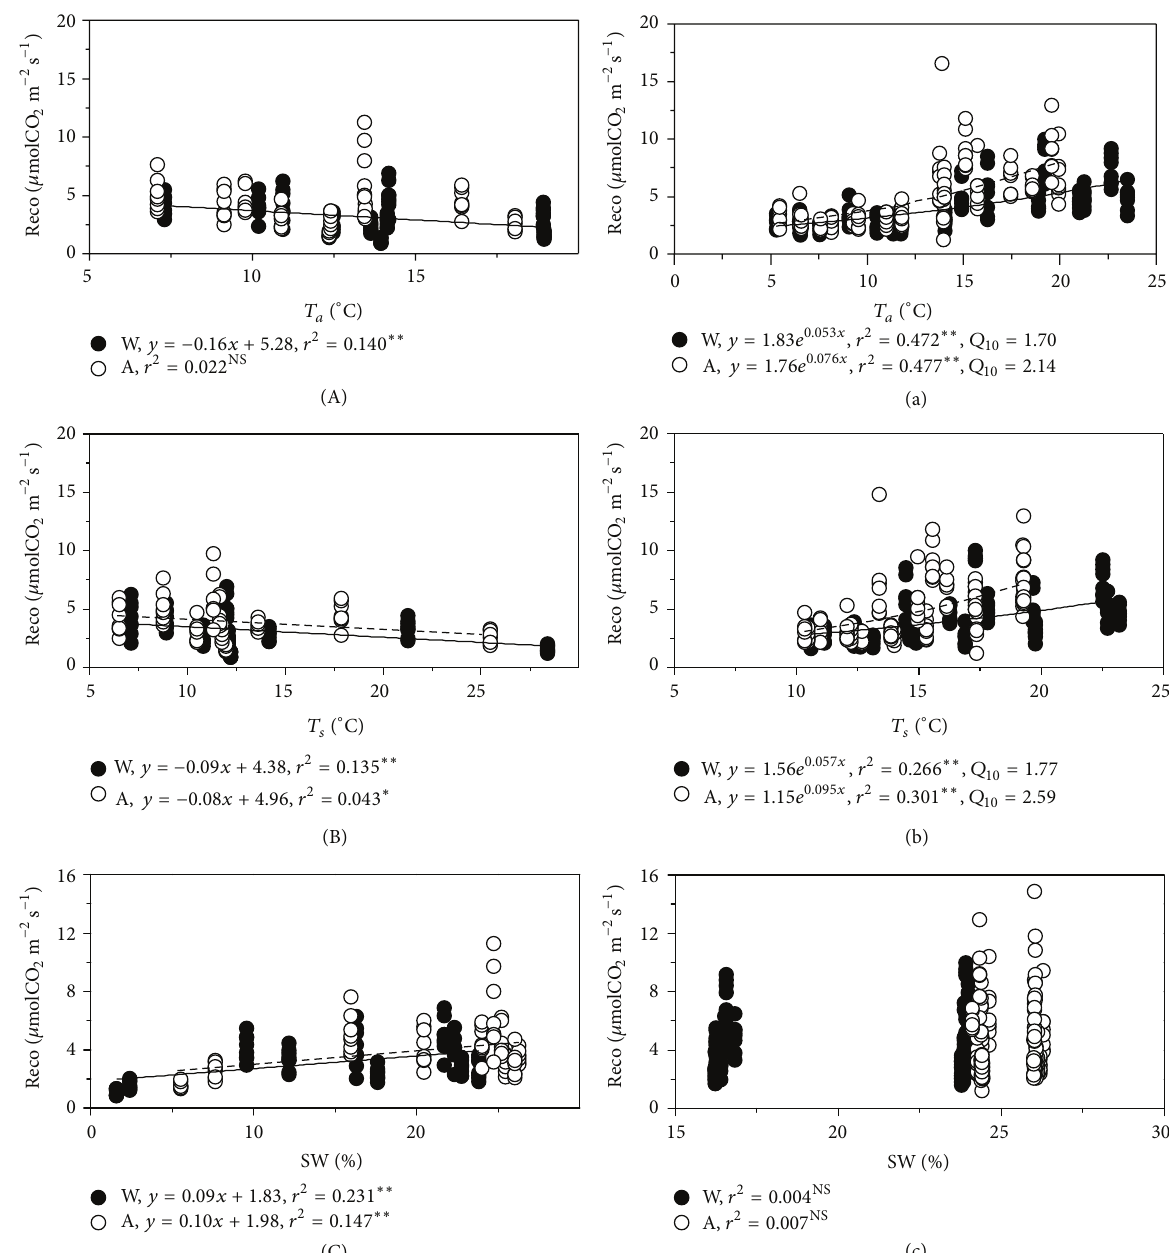
Figure 6: Dependence of soil respiration on air temperature (A, a), soil temperature (B, b), and soil water content (C, c) on seasonal (A, B, C) and diurnal (a, b, c) scales. Solid circles represent simulated warming treatment (W) and open circles represent ambient treatment (A). NS, ∗ , and ∗∗ represent significant levels 𝑃 ≥ 0.05 , 𝑃 < 0.05 , and 𝑃 < 0.01 , respectively. The following is the same. 𝑄 of ecosystem respiration to